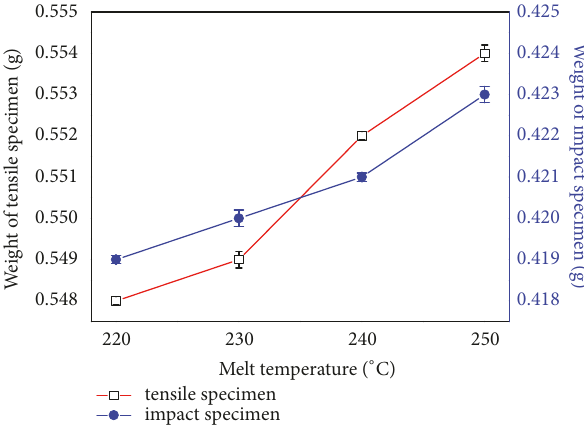
Figure 4: Influence of melt temperature on product weight.